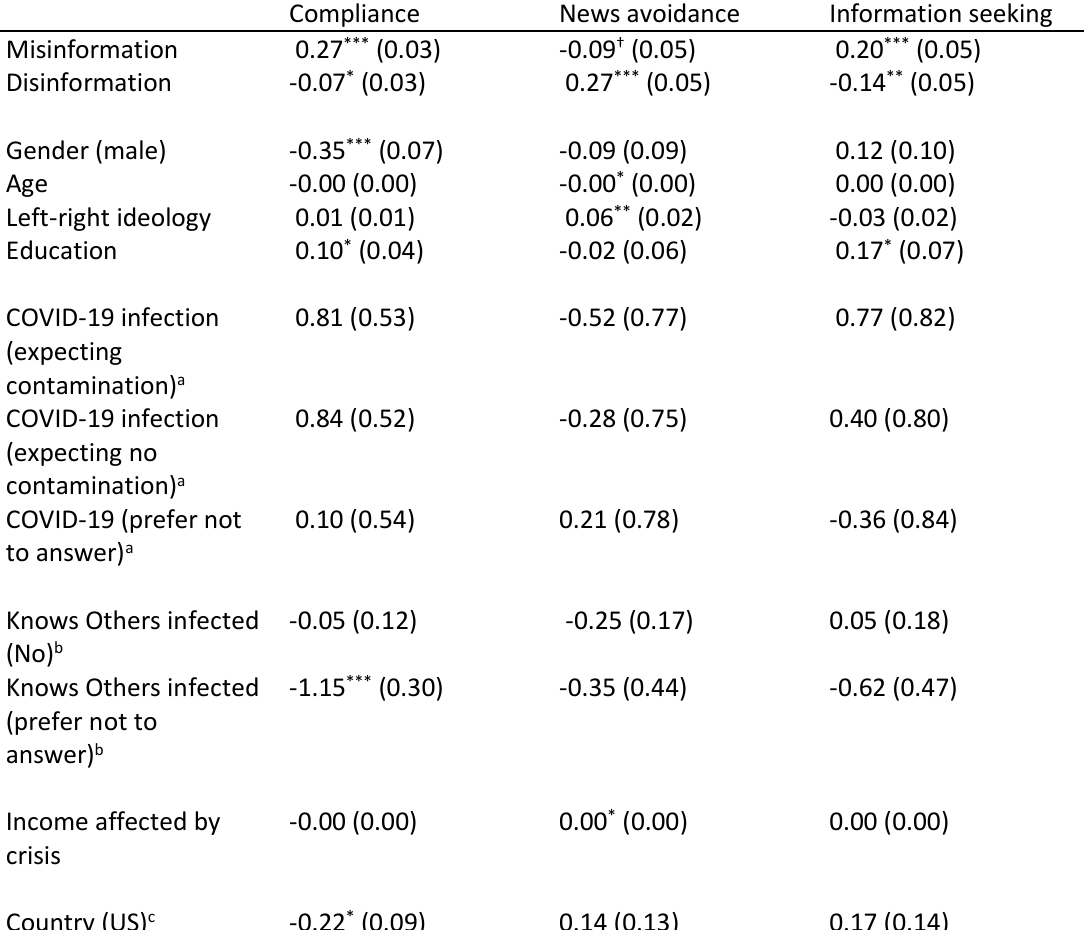
Table 1 . Willingness to comply, news avoidance, and intentional exposure among participants at higher levels of perceived mis- and